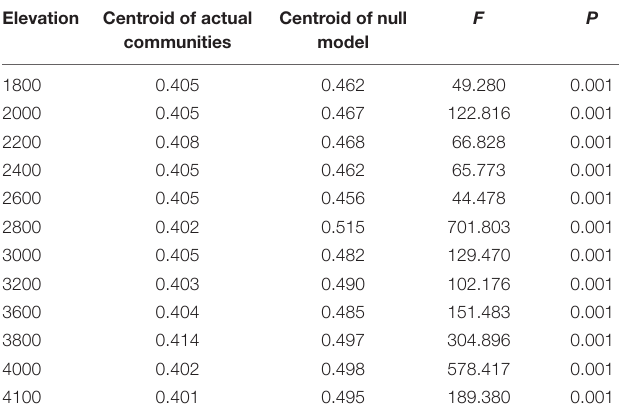
TABLE 2 | Jaccard distance-based significance tests of centroid differences between the observed communities and the null model simulations for each elevation using PERMDISP.